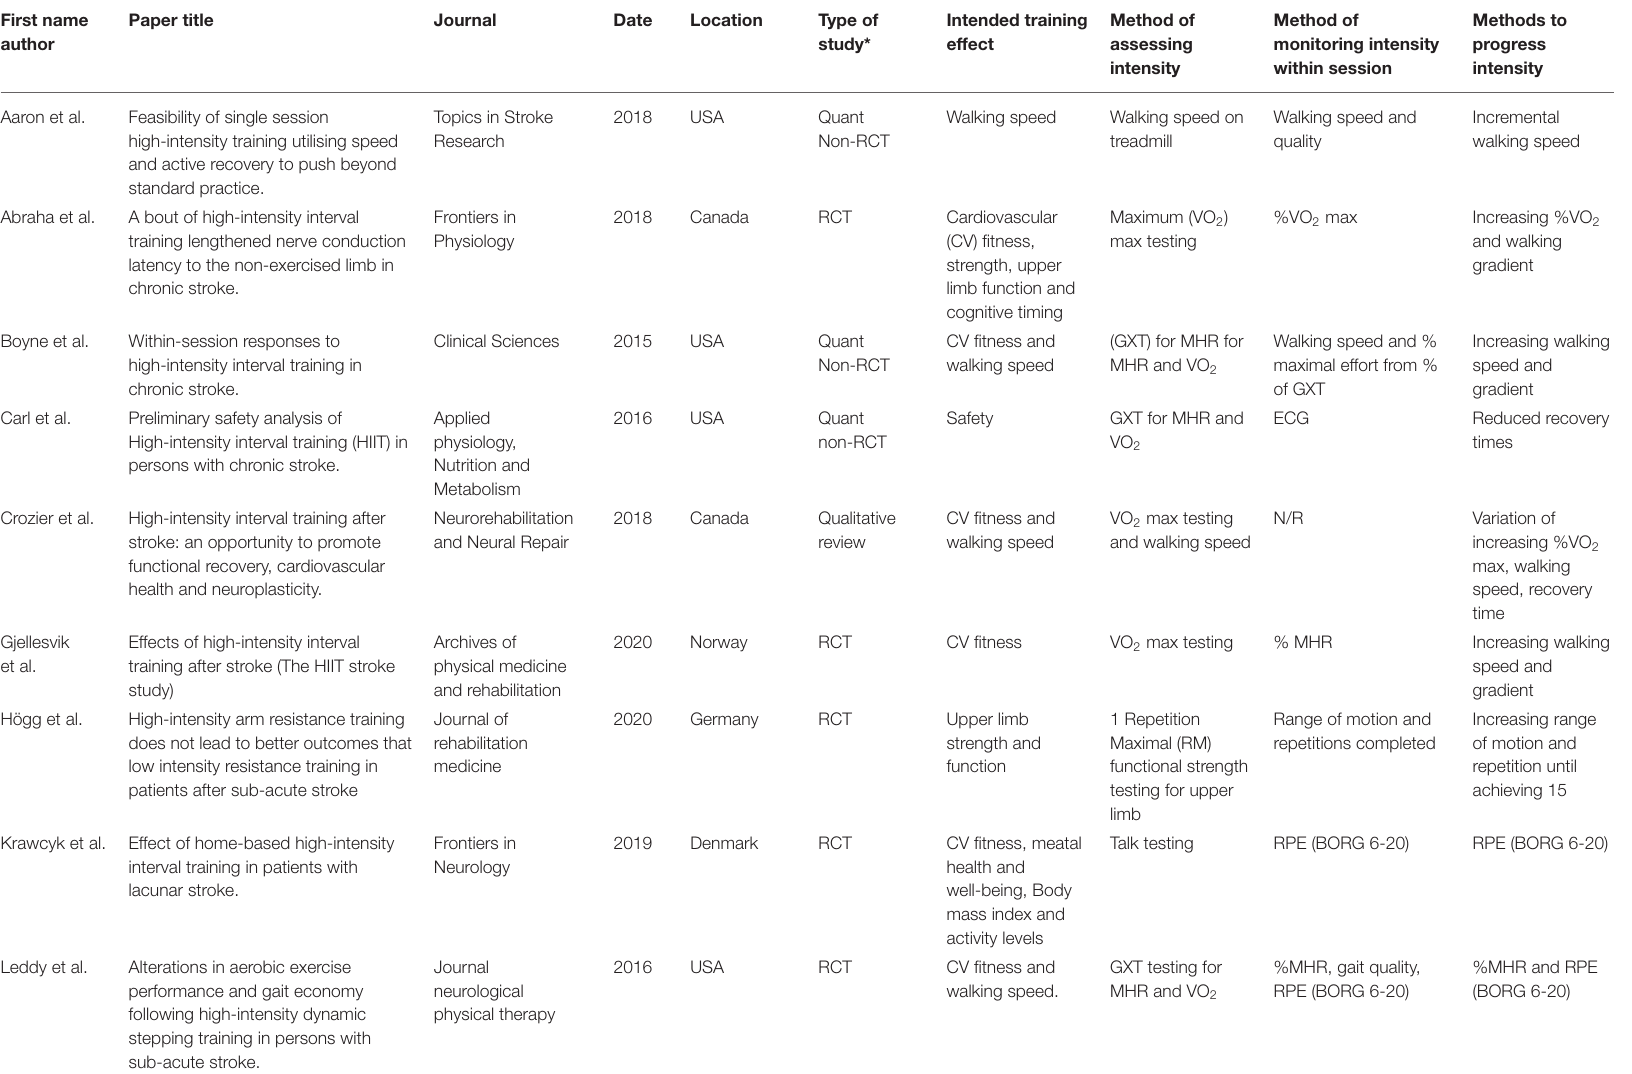
TABLE 3 | Summary results of included papers: type of study, training effect, methods for increasing